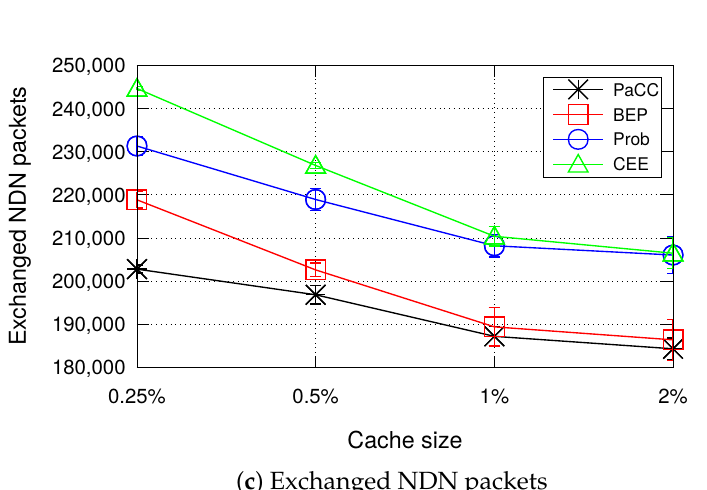
Figure 7. Metrics when varying the cache size of the edge domain from 0.25% to 2% of the content catalogue size (number of consumers equal to